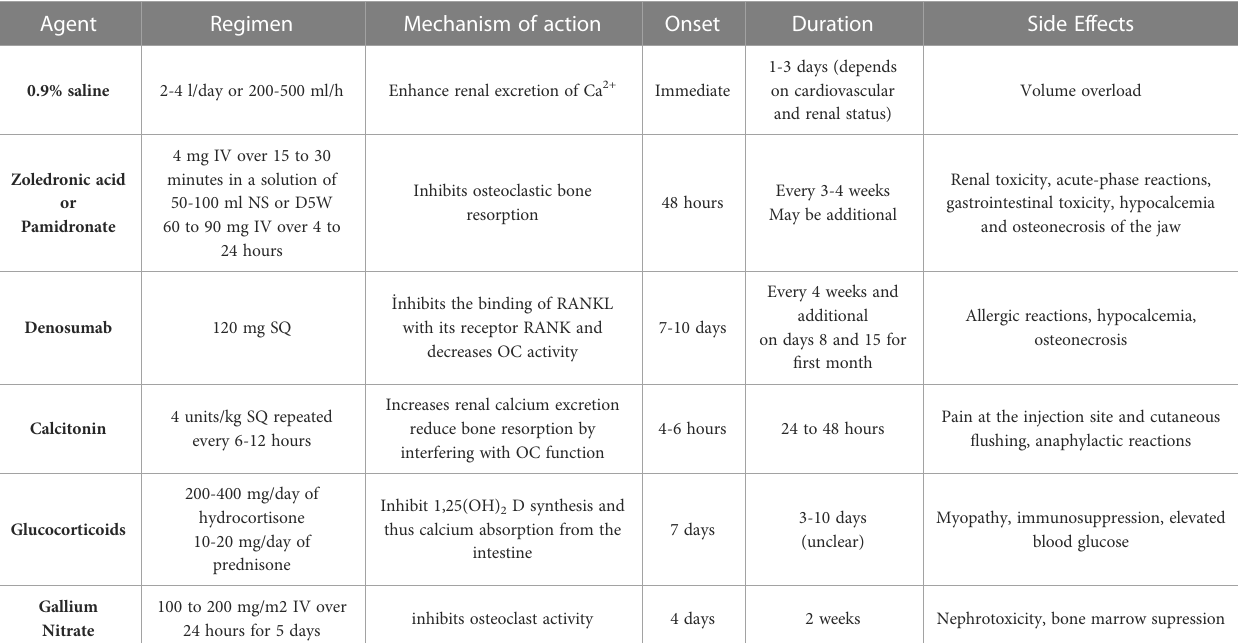
TABLE 1 Treatment options for hypercalcemia of